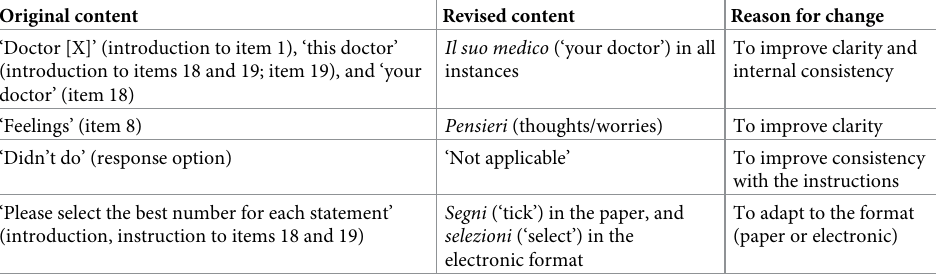
Table 1. Overview of revisions made to the 19-item Quality of Communication